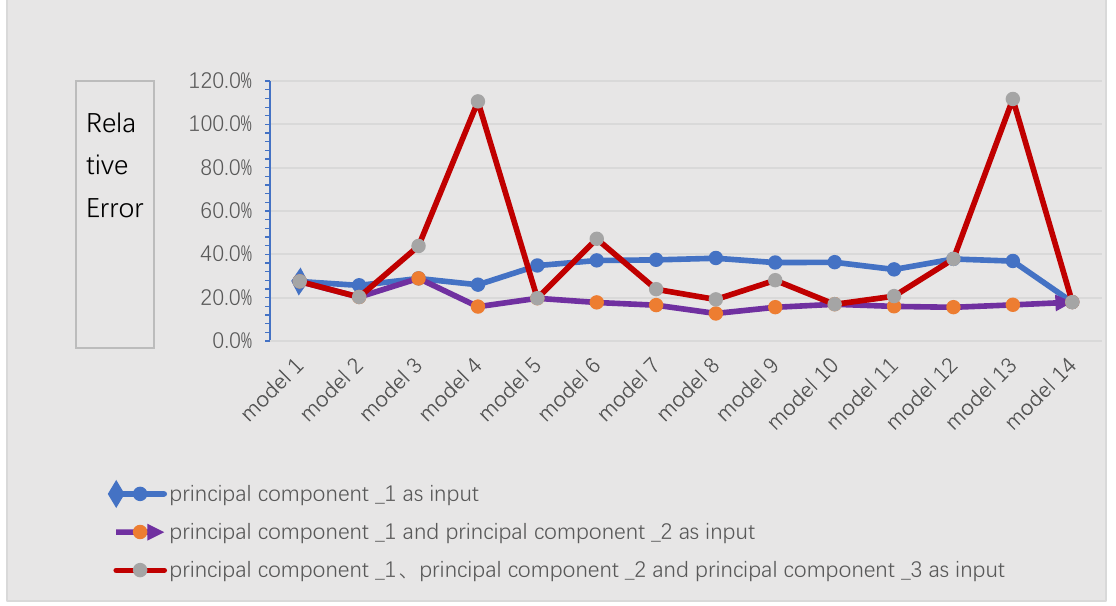
Figure 4. Maximum relative error of each model in the verification period.